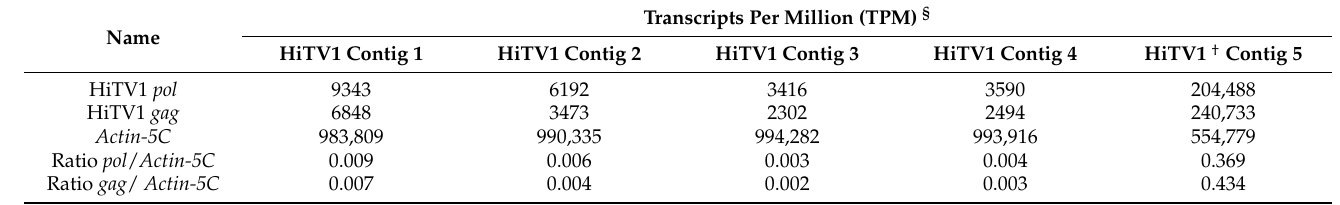
Figure 3. Phylogenetic relationships of HiTV1 within the family Totiviridae . The maximum likelihood tree is based on the concatenated alignment of POL and GAG sequences. Phylogenetic robustness was assessed using Shimodaira Hasegawa-like approximate likelihood ratio test and UF bootstrap; values are reported for each node. Host groups and virus genera are reported to the right side of the tree. Hermetia illucens toti-like virus 1 (HiTV1) is highlighted in bold in the tree. Virus clades belonging to genera, currently recognised by the International Committee on Taxonomy of Viruses (ICTV) are coloured for the illustrative purpose of highlighting that HiTV1 belongs to a new totivirus genus. Full names of abbreviations can be found in Table S4. Table 3. Sequence abundance of HiTV1 compared to BSF Actin-5C in different